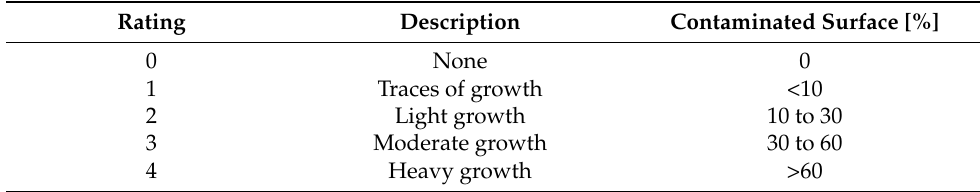
Table 3. Rate of mould growth (ASTM D 5590-17, 2017) [43].